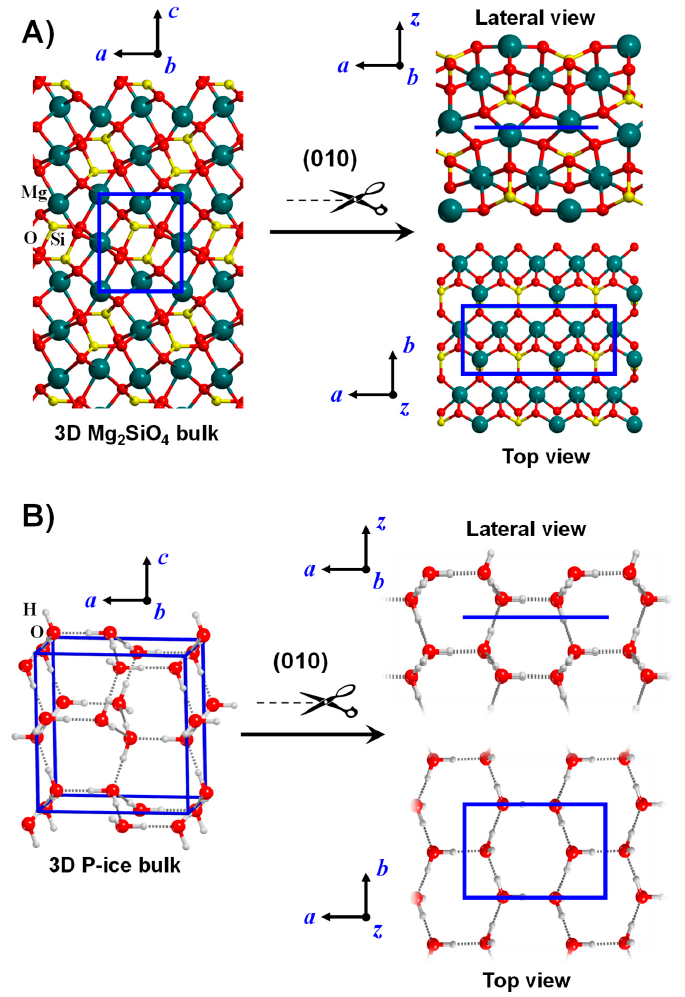
Figure 2. Bulk crystalline systems for Mg 2 SiO 4 ( A ) and water P-ice ( B ). The slab-cut procedure is shown to generate the corresponding (010) slab surface models. For the sake of clarity, both the lateral and the top views of the surface models are shown. Unit cells are represented in blue.